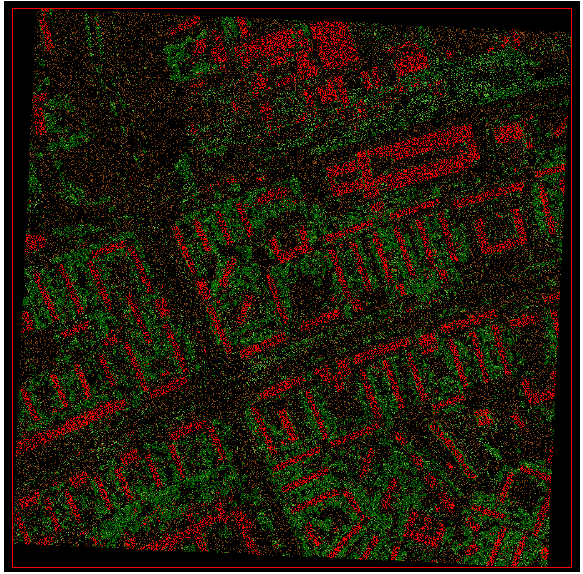
Figure 8. Automatic classification in Erdas IMAGINE.